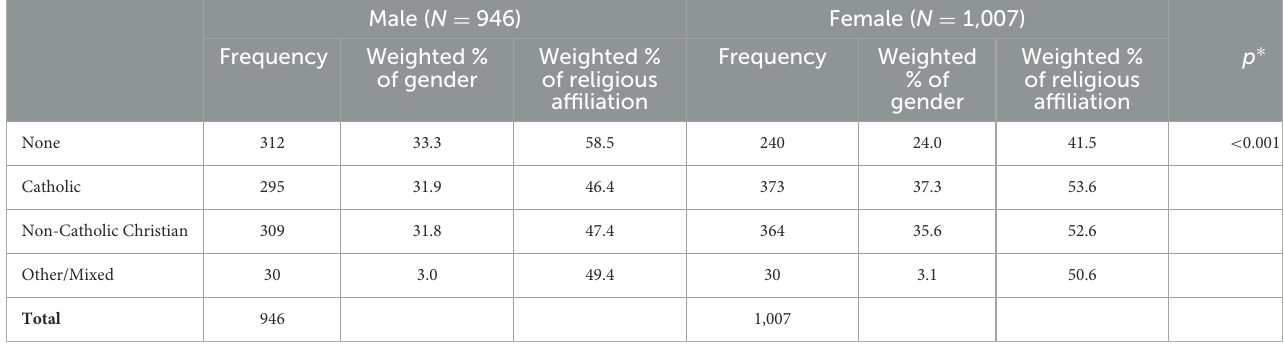
TABLE 2 Religious affiliation by